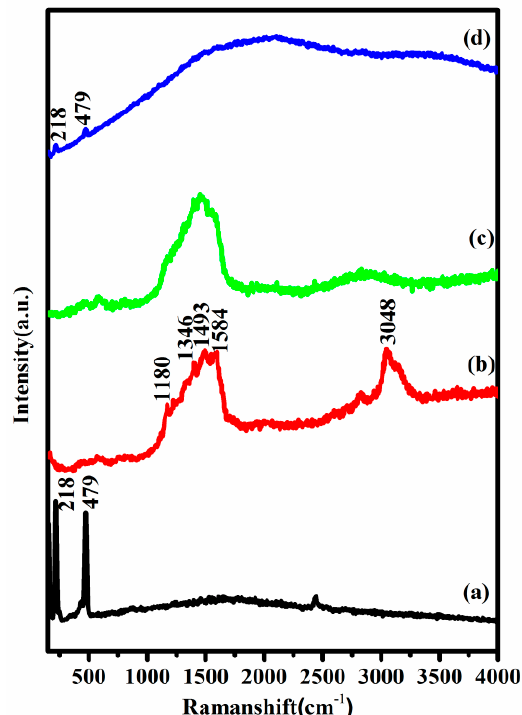
Figure 3. Spectra of ( a ) PS, ( b ) PAni, ( c ) PS / PAni, ( d ) Sulfur / post-treated sepiolite / PAni (S / PTSp / PAni).